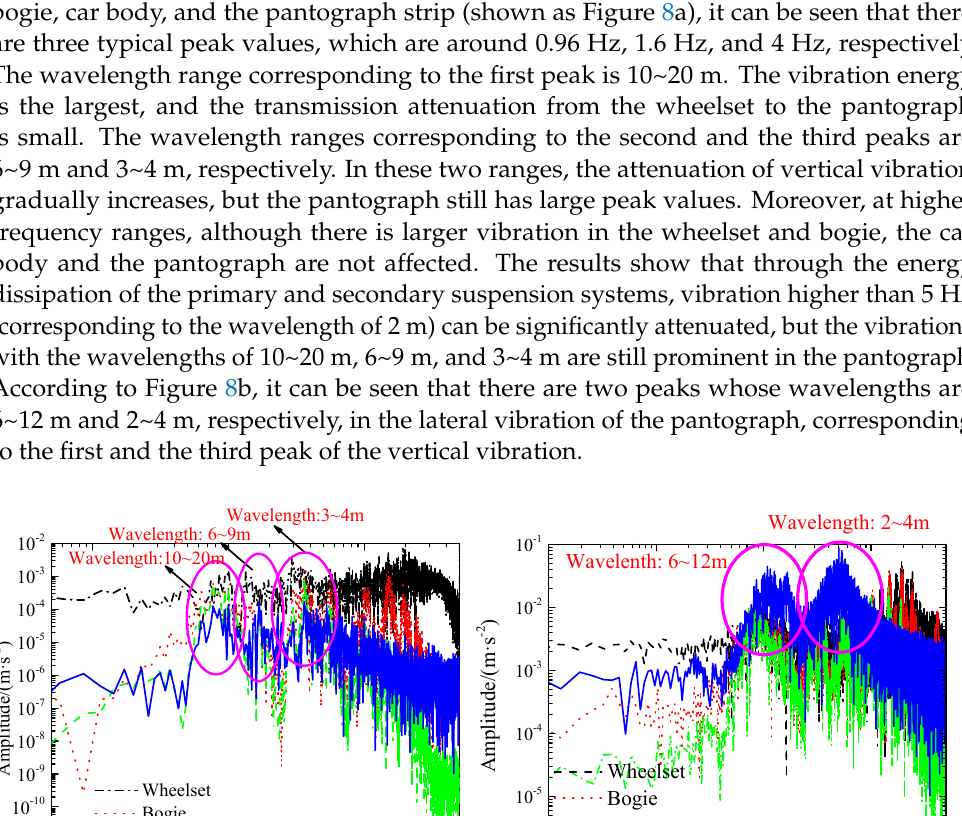
( b ) Figure 9. Vibration responses of the vehicle system at 53 km/h: ( a ) vertical responses; ( b ) lateral re- sponses. It can be seen that with the increase in the operating speed, the dynamic responses of the vehicle system increase, and the peak frequency of the vibration also increases. However, for vertical vibration, the wavelengths corresponding to the vibration peaks of the pantograph are still 10~20 m, 6~8 m, and 3~4 m, respectively, which are exactly the same as those at 42 km/h. In terms of lateral vibration, it can be seen that the vibration of the pantograph has increased significantly, and the peaks are concentrated in the two frequency ranges of 9.6~13.4 m and 3~4 m. According to the measured track geometry irregularity, it can be inferred that its two broadband peaks at 10~20 m and 3~4 m have a great influence on the vibration of the vehicle system, especially the pantograph strip. 4.2. PC Contact Forces The PC normal force and lateral friction force at speeds of 42 km/h and 53 km/h were extracted and transferred to the frequency domain. The results are shown in Figure 10.